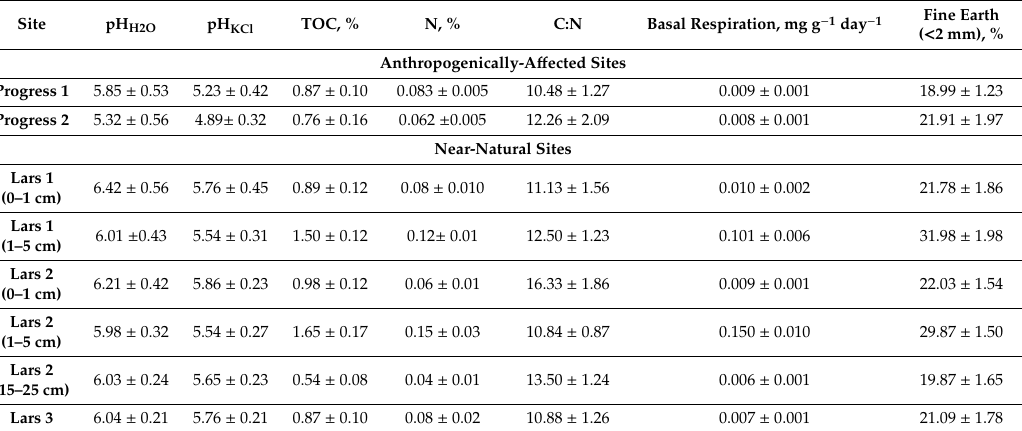
Table 3. Soil physical–chemical parameters ±